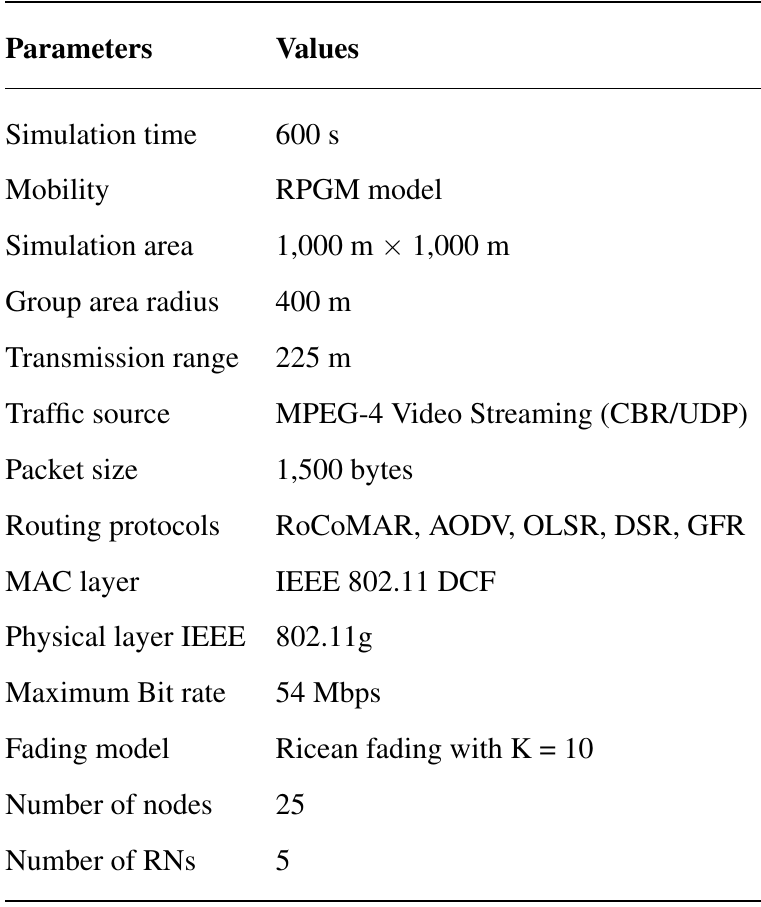
Table 1. Simulation Parameters and